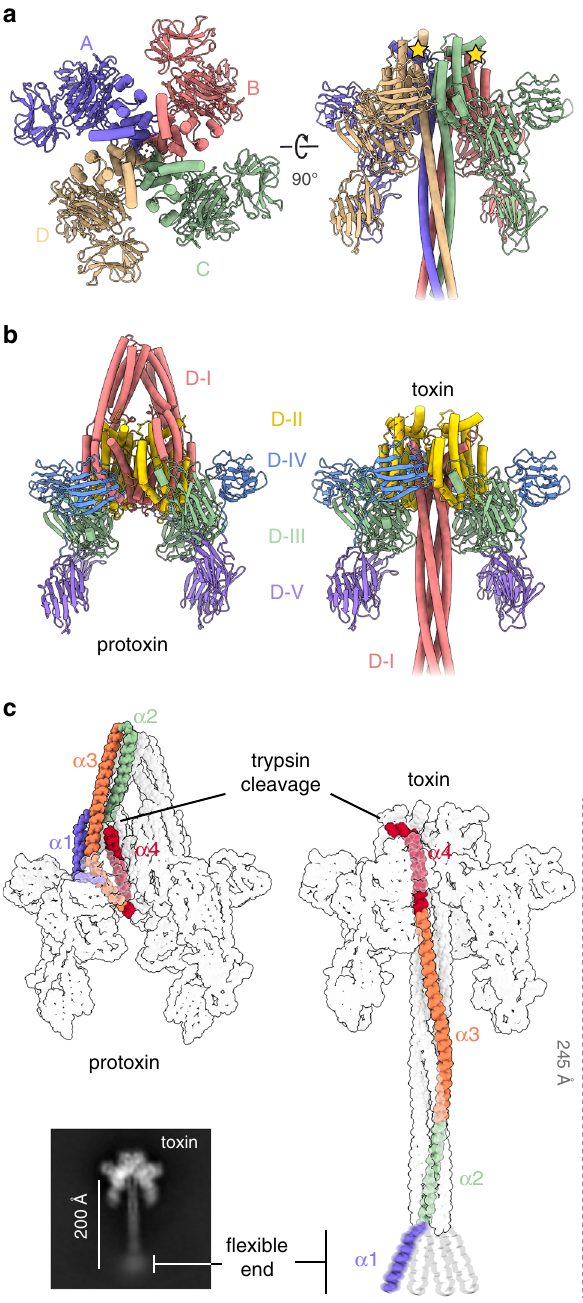
Fig. 3 Molecular architecture of the trypsin activated Vip3Aa toxin. a Two orthogonal views of the Vip3Aa toxin show that the four monomers are organized around a central pore. The different monomers have been colored as in Fig. 1a. Yellow stars indicate the position of the trypsin cleavage site in two of the monomers. b Similar views of the Vip3Aa protoxin and toxin colored by domain organization as in Fig. 1b. Domains are labeled as D-I through D-V c The alpha helices that comprise domain I undergo a large reorganization that leads to the formation of an extended coiled coil. The four helical bundle is ordered starting from residue ~45, and reference-free 2D averages show that the most N-terminal region appears to be fl clear, a recent study indicates that they have a strong preference for chitosan and chitin 29 , and the DALI server revealed that they show similarity to glycoside hydrolases, which are often found in tandem to increase af fi nity for polysaccharides 30,31 .